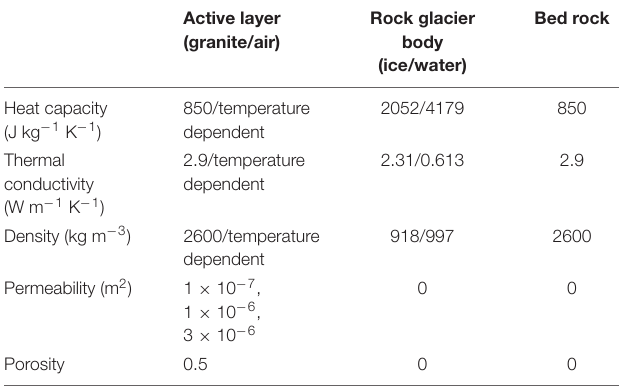
TABLE 1 | Properties of the geometry for COR and SBE. Slope angle Active layer ( ◦ ) thickness (m)